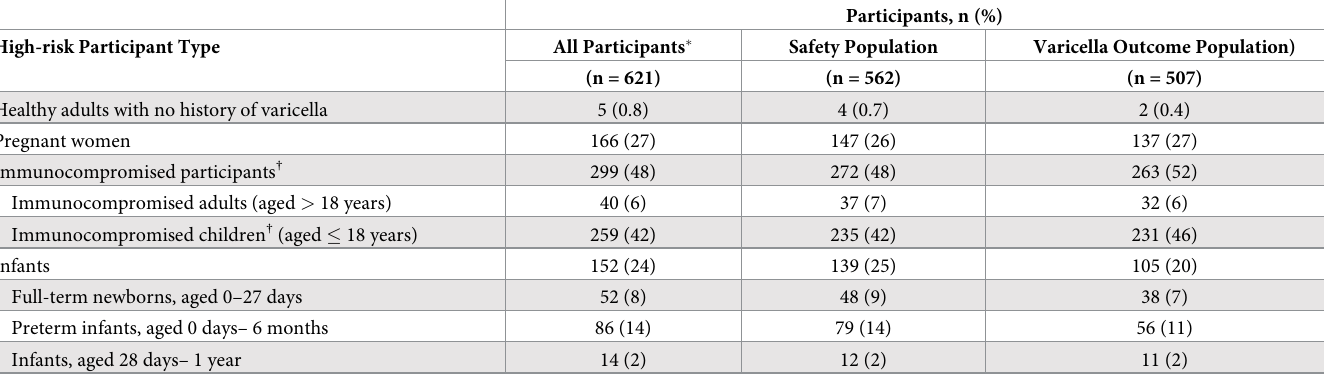
Table 1. Distribution of participants who received